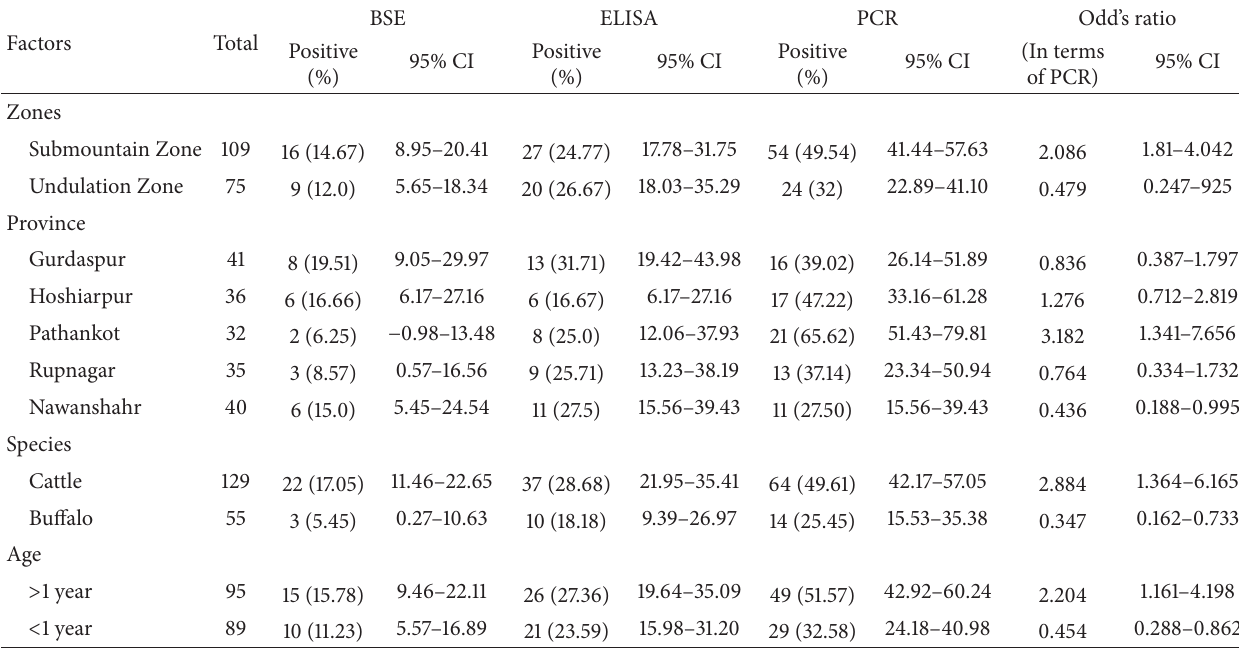
Table 1: Incidence of A. marginale among different districts and animal groups under study as diagnosed by Blood Smear Examination (BSE), Enzyme Linked Immunosorbent Assay (ELISA), and Polymerase Chain Reaction